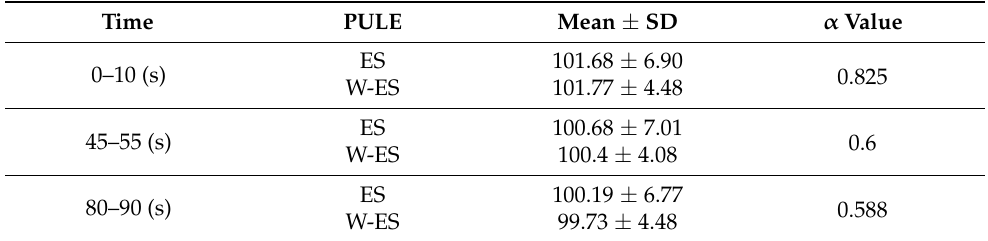
Table 4. Mean change in the lifting angle of the upper limb and α value before and after wearing the PULE for pesticide spraying simulation ( n = 18).